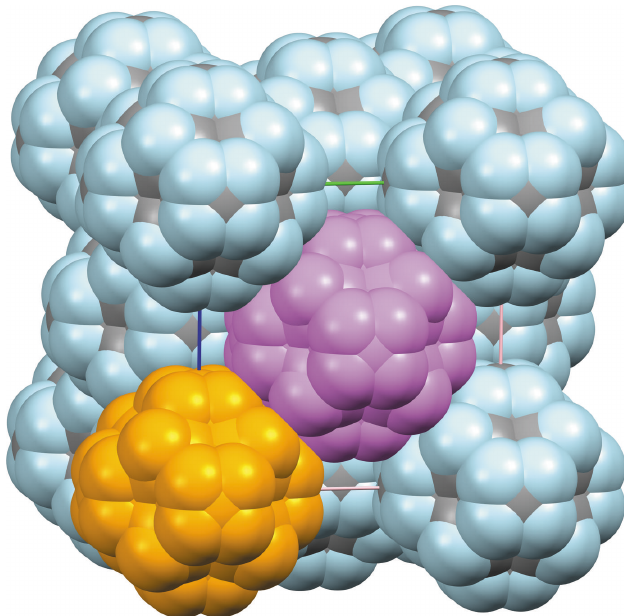
Figure 5 Packing structure of cyclohexane at 255 K, in a space-filling representa- tion. All disordered sites for C (grey) and H (blue) atoms in one unit cell are represented with their van der Waals radii (Macrae et al. , 2020). Two neighbouring clusters of disordered molecules in the fcc lattice are shown in orange and magenta, with the purpose of emphasizing the contact between the two clusters. The interface separating the clusters is a ‘diagonal’ mirror plane m in space group Fm 3 m